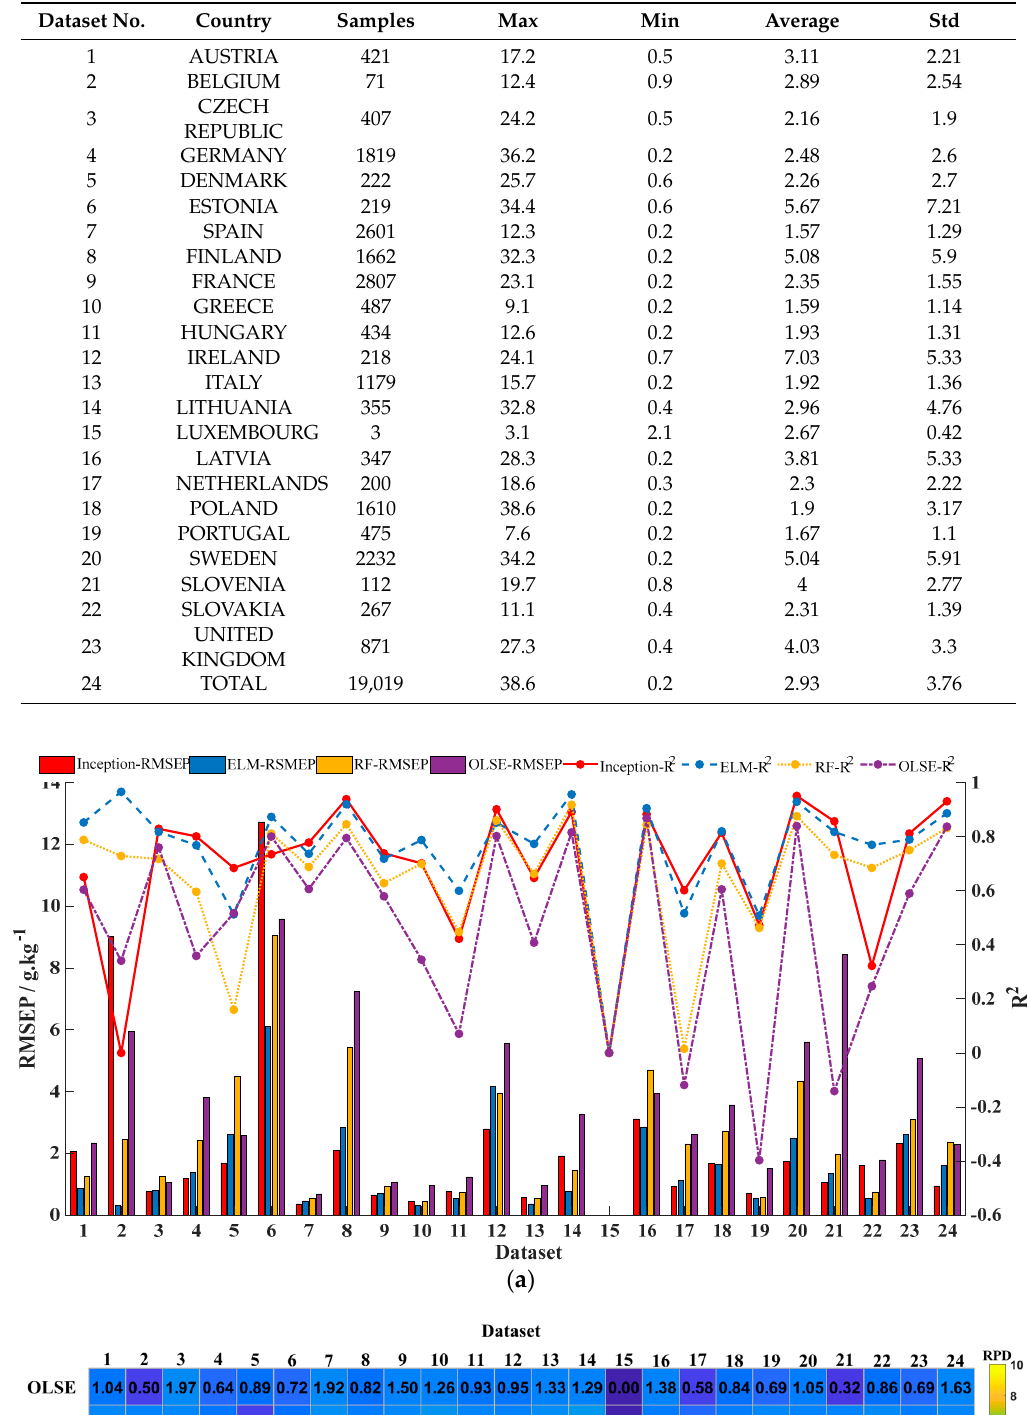
Table 6. Description of the datasets with di ff erent countries.